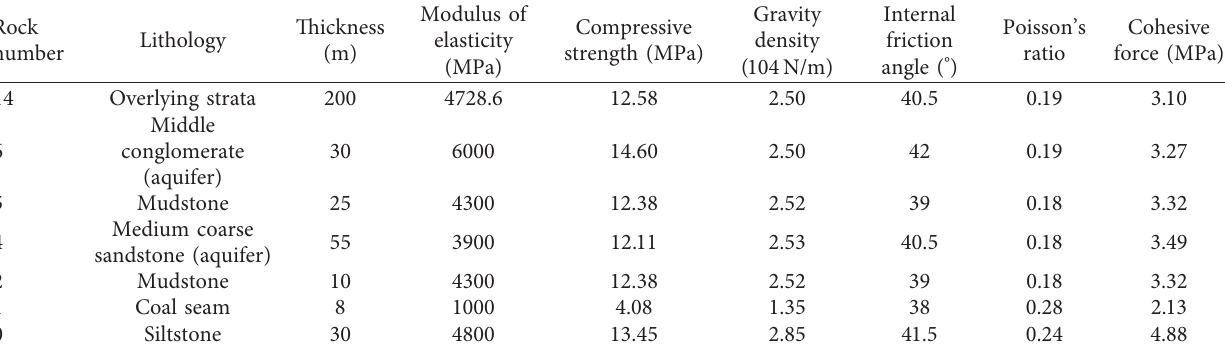
Table 1: Parameter table of rock stratum and rock mechanical